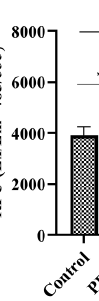
Figure 5. Acid sphingomyelinase activation by PF-543 and DPF-543 treatment. Data are shown as means ± SD, ns—not significant, ** p < 0.01, *** p < 0.001.